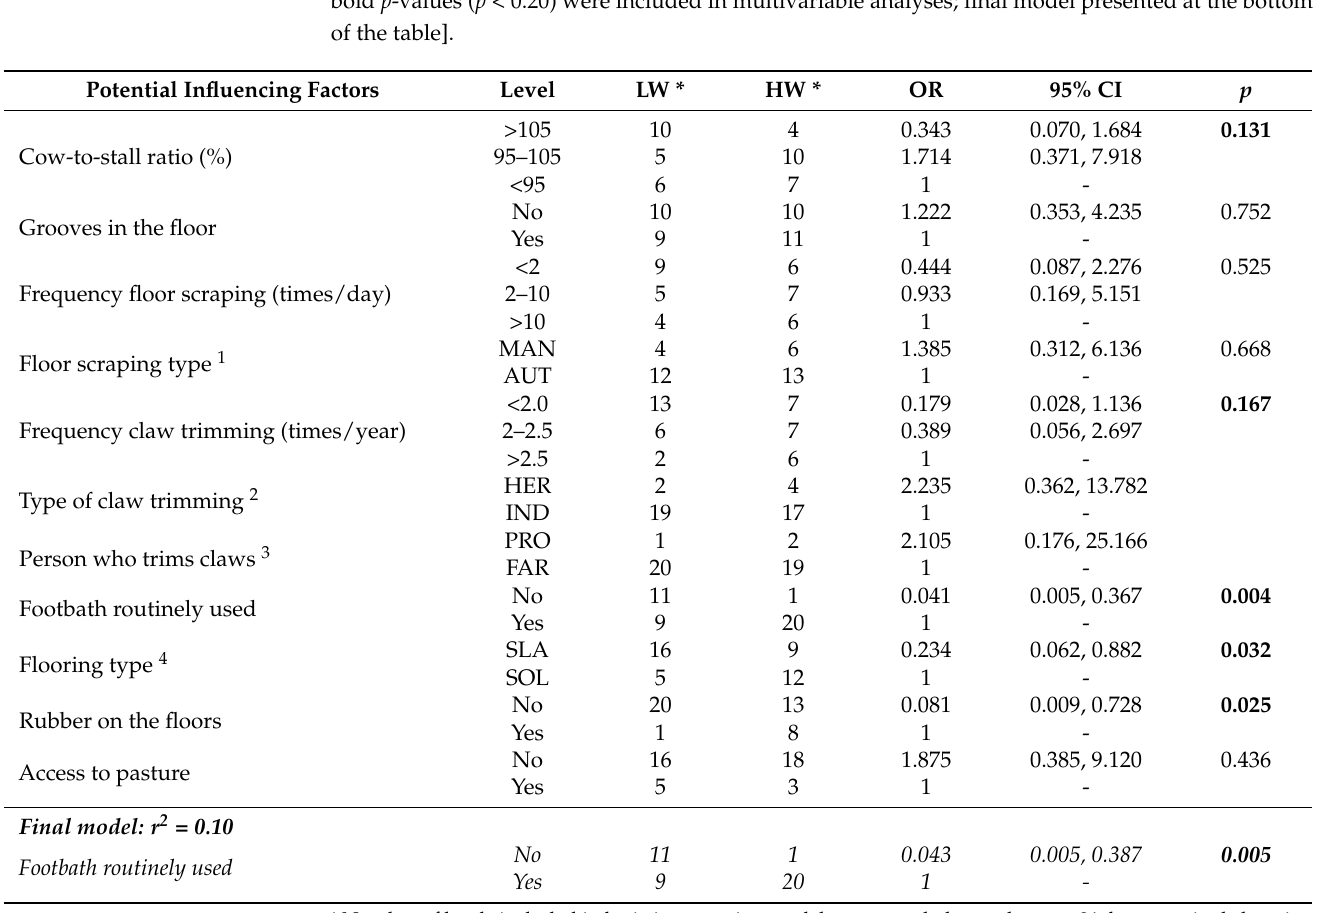
Table 6. Potential influencing factors in univariable logistic regression analysis associated with being a herd with high welfare level (HW) within the indicator “lameness” [Odds ratio, confidence interval, bold p -values ( p < 0.20) were included in multivariable analyses; final model presented at the bottom of the